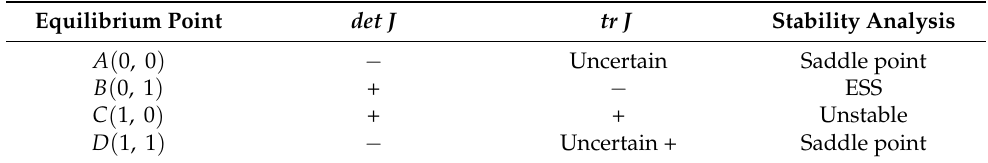
Table 5. Stable equilibrium analysis in scenario 2.